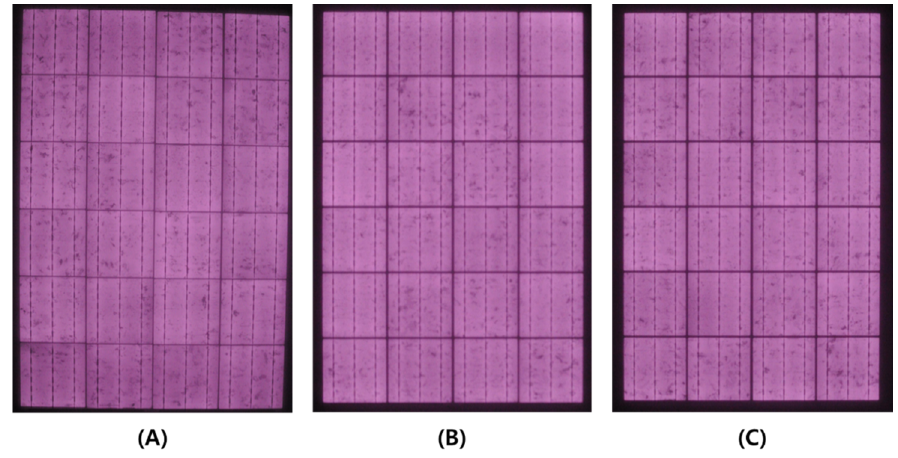
Figure 6. Electroluminescence (EL) image of PV module; ( A ) UBF 24-cell ( B ) ETFE 24-cell PV module; ( C ) ECTFE 24-cell PV module.